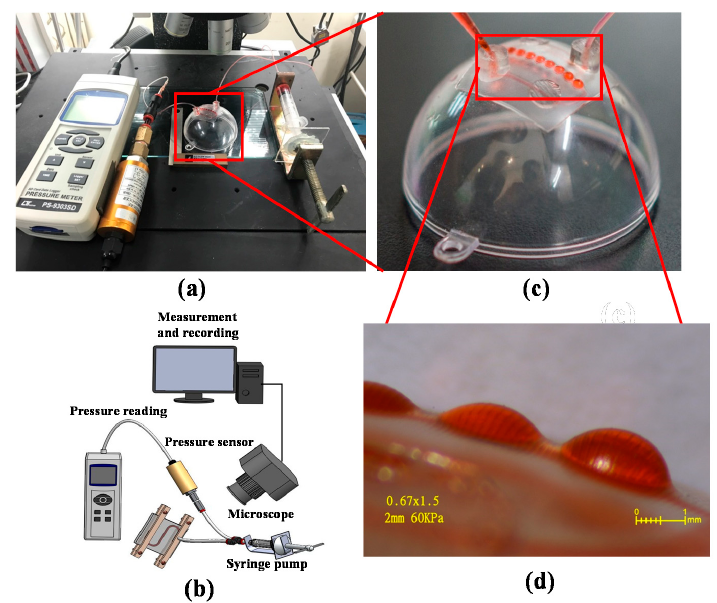
Figure 7. ( a ) Nonplanar ‐ cast PDMS membrane; ( b ) PDMS membrane bonded on a hemispherical PMMA substrate.